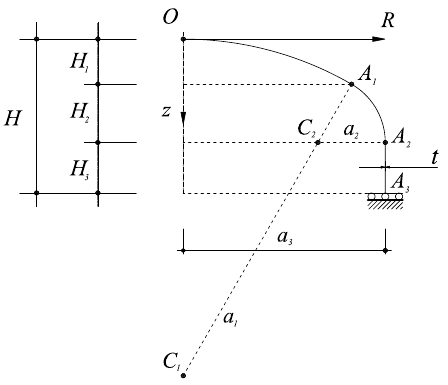
Figure 15. Torispherical tank subject to uniform internal pressure. Cross